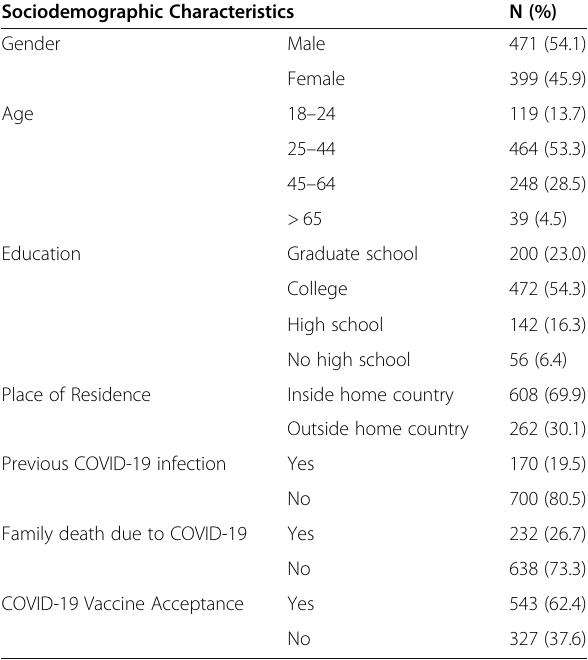
Table 1 Sociodemographic and Other Characteristics of the Study Population ( N = 870) Sociodemographic